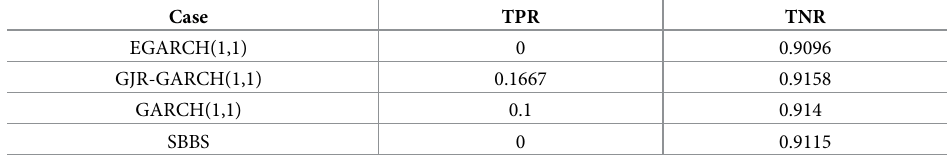
Table 3. Classification metrics for asymmetric dependencies. TPR and FNR for the binary ETE of estimated expected returns in relation to the binary ETE of historical returns.